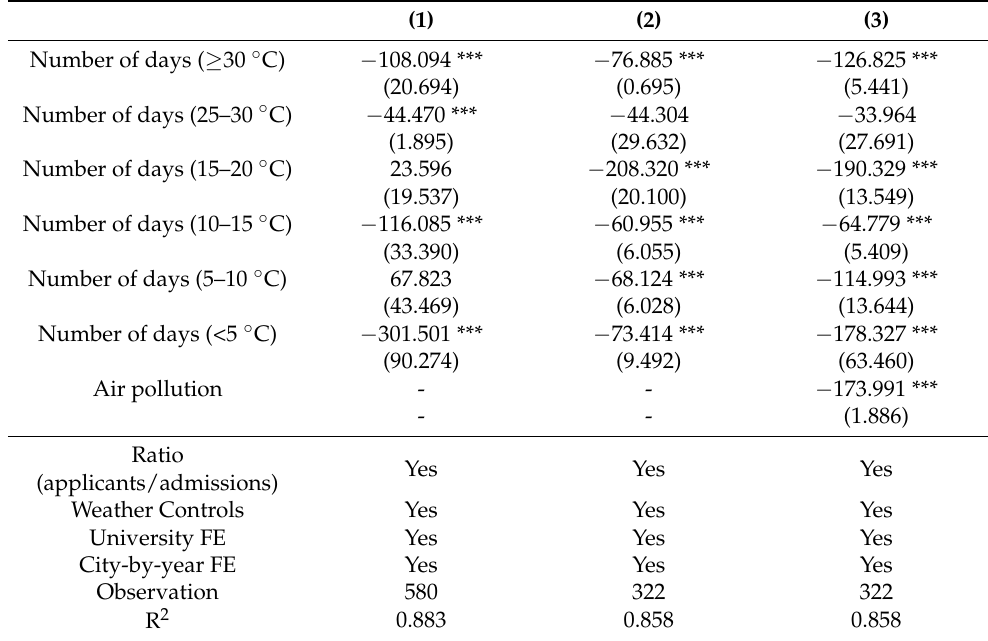
Table 5. Robustness checks: air pollution as a possible confounder.